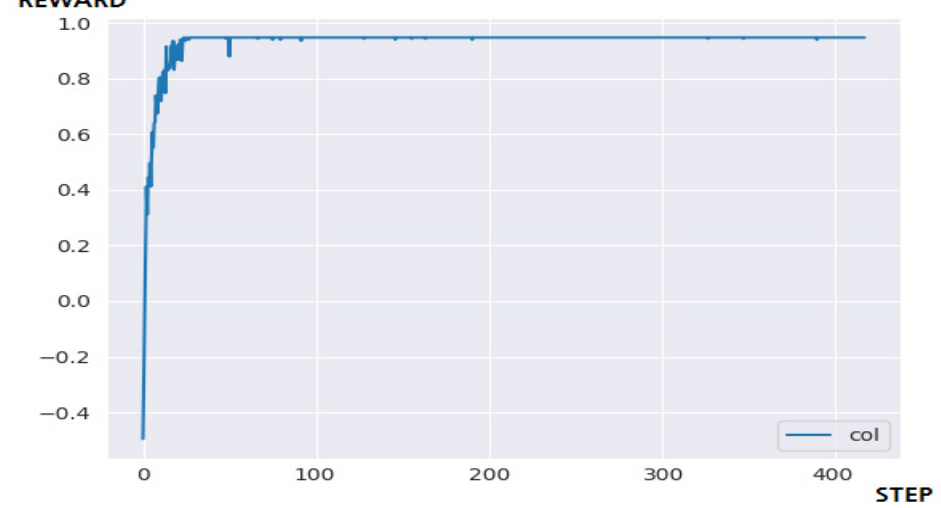
Figure 8. The result of a 5 × 5 maze game through Q-Learning.